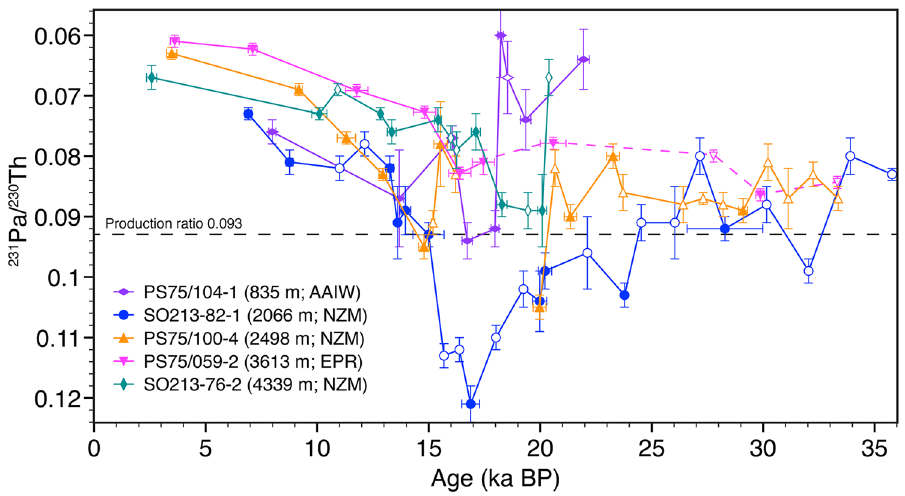
Figure 3. Patterns of deep-water 231 Pa/ 230 Th. Dashed pink line indicates time interval when influences by the advancing glacial opal belt cannot be ruled out (supplementary information). Filled symbols—samples with parallel 14 C measurements. Please note that 14 C-Age error bars are sometimes smaller than the symbols